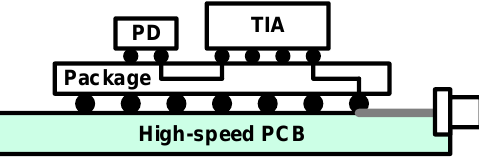
Figure 14. Illustration of flip-chip package [54].